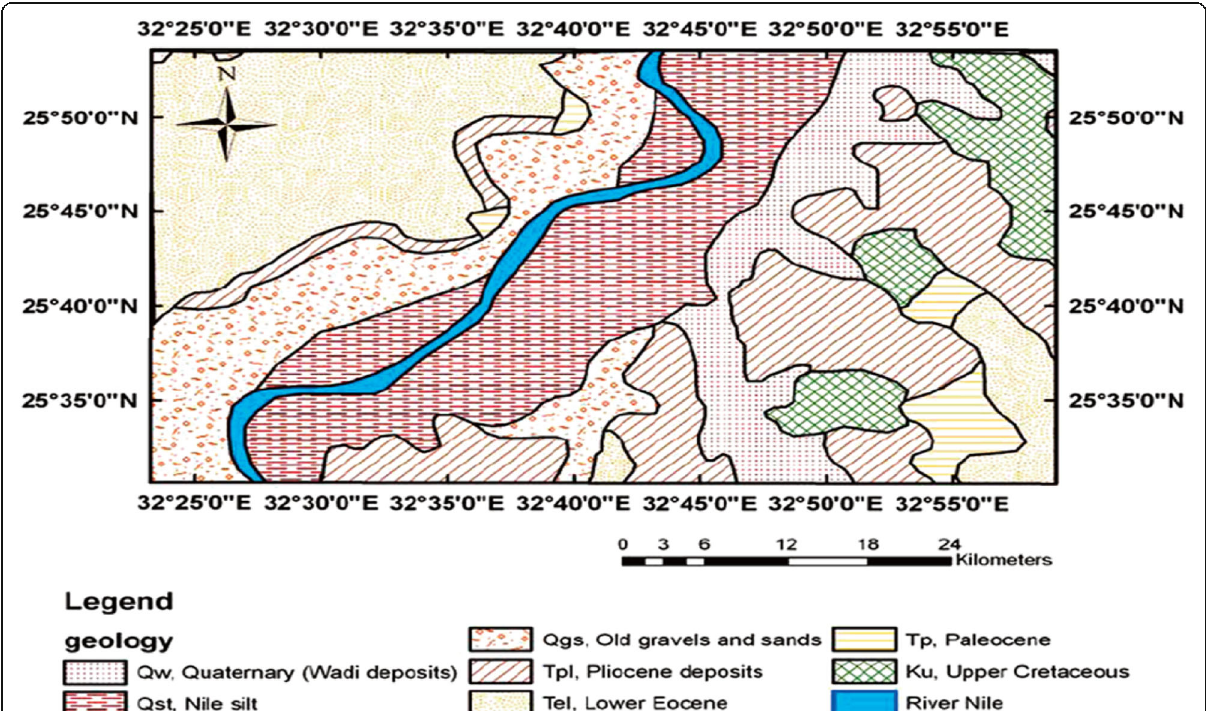
Fig. 5 Geological setting of the Valley of the Kings, Luxor, Egypt. (Geological Egyptian Authority). The Thebes formation exposed in the valley of kings could be subdivided into three members (from base to top) Hamadat, Beida and Al-Geer members however, the Thebes formation conformably overlying the Esna Shale. The lower member Hamadat is white, chalky indurated limestone with flint concretions, the middle member Beida is made up indurated, thick bedded, nodular limestone with flint bands extending parallel to the bedding planes, the uppermost member Al-Geer consists mainly of white limestone